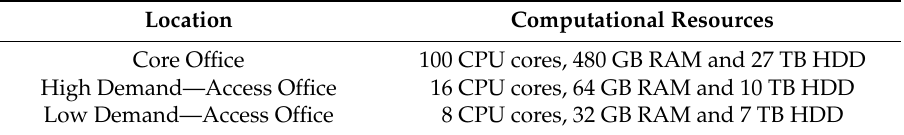
Table 1. IT resource distribution in CO and AOs [13,23].